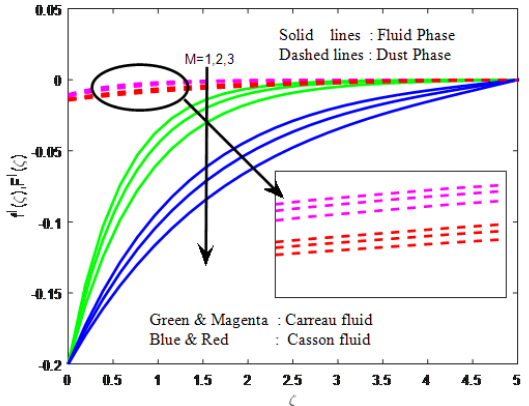
Fig. 5: Impact of ϕ on temperature profiles.